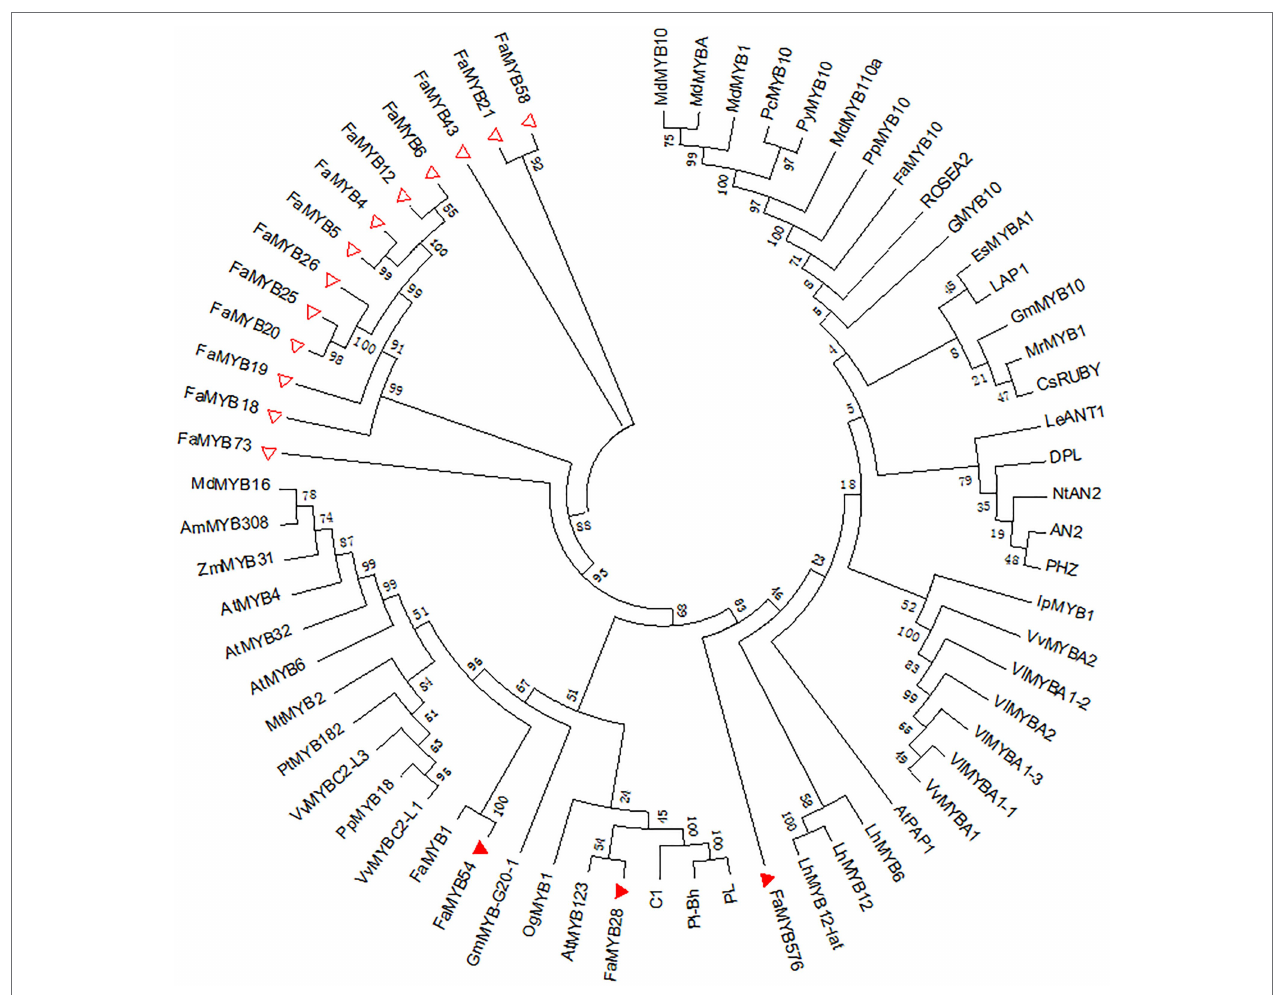
FIGURE 6 | Phylogenetic analysis of the differentially expressed R2R3-FaMYB genes in pink-flowered strawberry and other anthocyanin-related R2R3-MYBs. Triangles represent differentially expressed R2R3-FaMYBs in pink-flowered strawberry. The amino acid sequences were retrieved from GenBank databases. Anthocyanin-related MYBs: AtMYB4 (NP_195574), AtMYB123 (NP_198405), AtMYB32 (NP_195225), AtMYBPAP1 (NP_176057), AtMYB6 (NP_192684.1), MdMYB1 (HQ259417), MdMYB10 (EU518249), MdMYB110a (JN711473), MdMYBA (AB279598), MdMYB16 (HM122617.1), MrMYB1 (ADG21957), GMYB10 (CAD87010), VvMYBC2-L1 (AFX64995), VlMYBA1-1 (BAC07537), VlMYBA1-2 (BAC07539), VlMYBA1-3 (BAG55463), VlMYBA2 (BAC07540), VvMYBA1 (BAD18977), VvMYBA2 (BAD18978), VvMYBC2-L3 (KM046932.1), EsMYBA1 (AGT39059), IpMYB1 (AB232769.1), LAP1 (ACN79541), LhMYB6 (BAJ05399), LhMYB12 (BAJ05398), LhMYB12-Lat (BAO04194), C1 (AAA33482), PL (AAA19820), PL-BH (AAA33492), GmMYB10 (ACM62751), PpMYB10 (ABX79945), CsRUBY (AFB73913), OgMYB1 (ABS58501), PcMYB10 (ABX71487), PyMYB10 (ADN26574), FaMYB1 (AAK84064), FaMYB10 (ABX79947), AN2 (AAF66727), DPL (ADW94950), PHZ (ADW94951), ROSEA2 (DQ275530), GmMYB-G20-1 (BAK24100), NtAN2 (ACO52470), LeANT1 (AAQ55181), PpMYB18 (KT159234.1), PtMYB182 (AJI76863.1), MtMYB2 (AES99346.1), AmMYB308 (CAA75691.1), and ZmMYB31